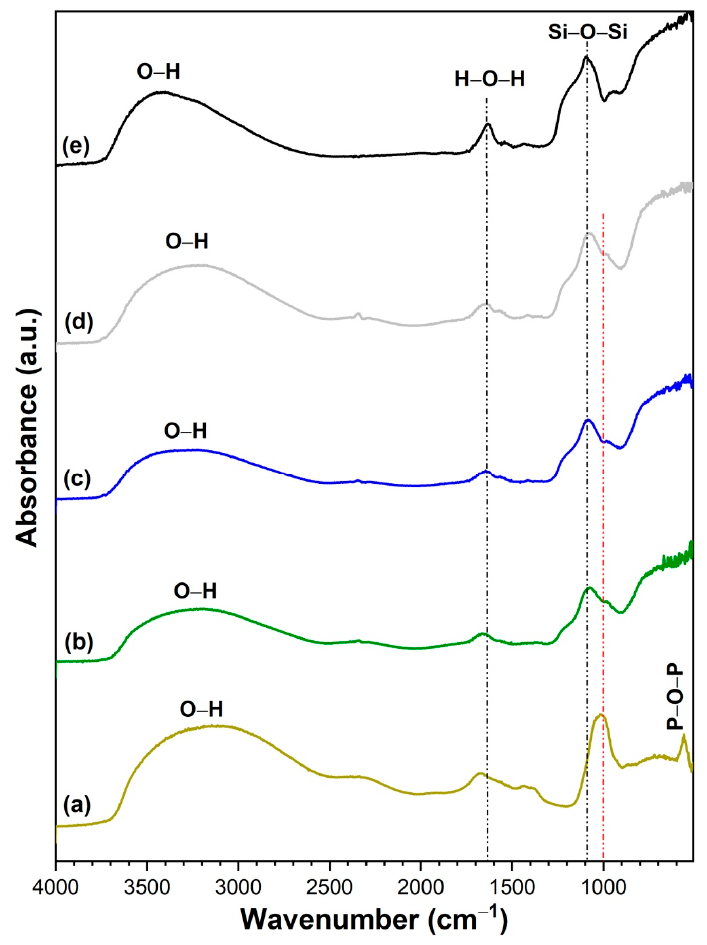
Figure 3. FTIR spectra of ( a ) Ag 3 PO 4 , ( b ) TS82-AgP4, ( c ) TS82-AgP8, ( d ) TS82-AgP16, and ( e ) TS82 microspheres.